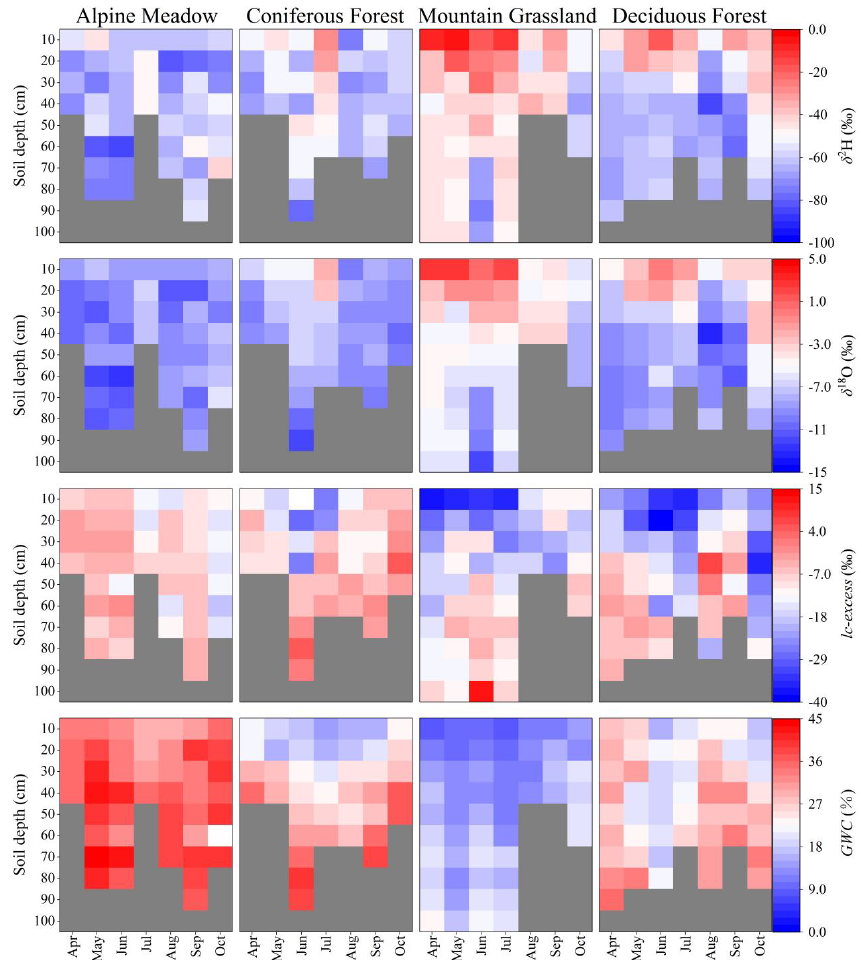
Figure 4. Heat map of the soil depth profile of δ 2 H, δ 18 O, lc-excess and GWC in different vegetation zones, and the layer lacking measure- ment is indicated by the gray color.